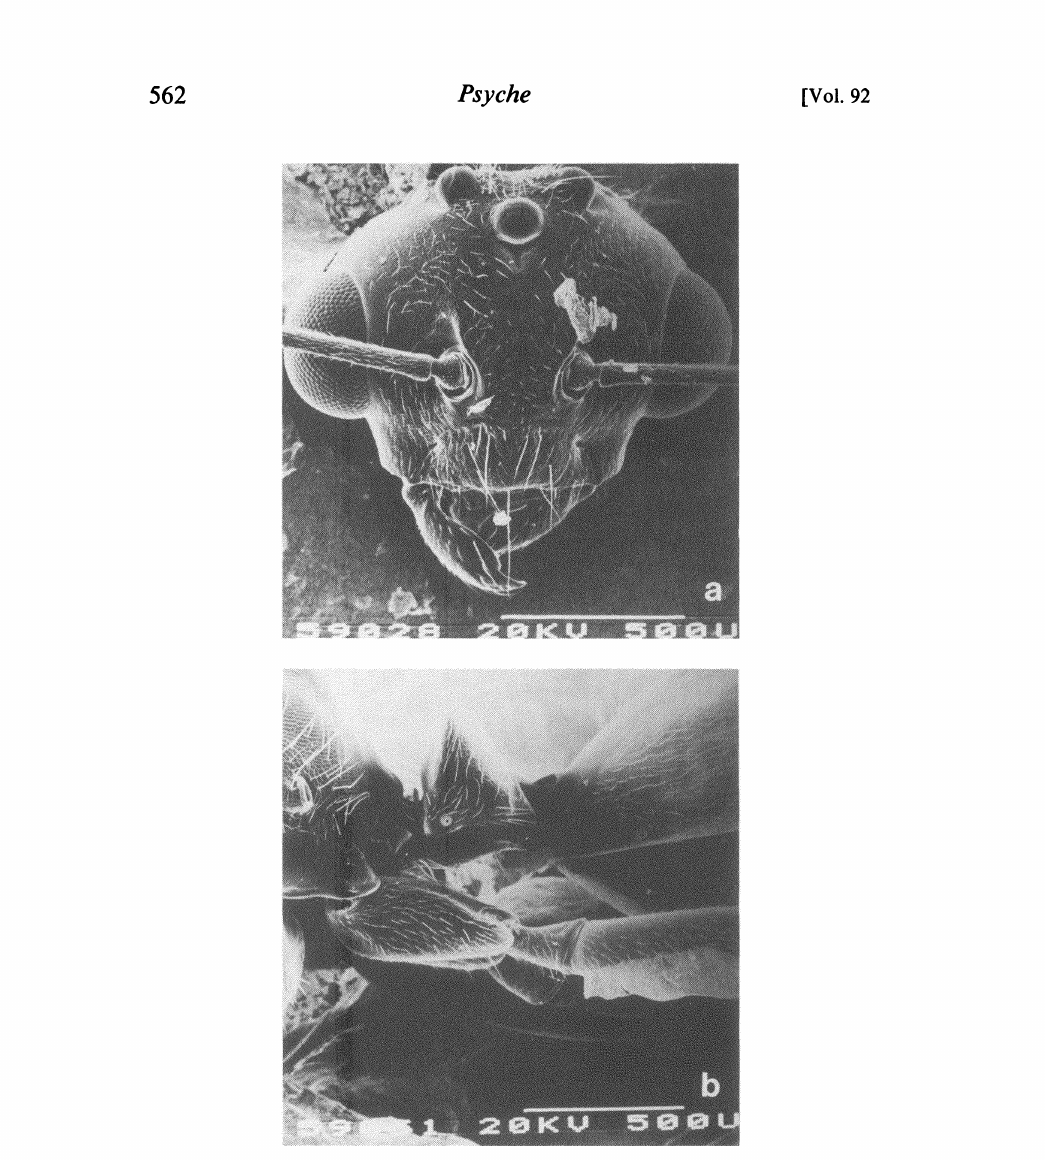
Fig. 2. Scanning electron micrograph of Camponotus texens male: a, head; b, petiole of alitrunk and gaster in